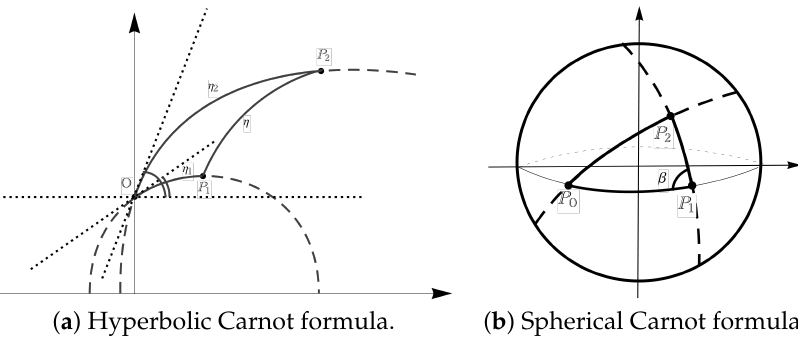
Figure 2. Relationships between sides and angles in hyperbolic